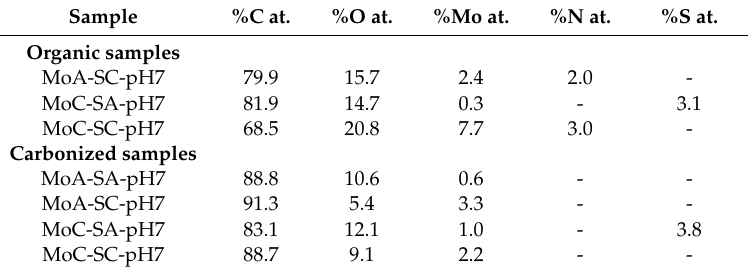
Table 1. Atomic surface composition of Mo-doped xerogels obtained by XPS analyses before and after carbonization. Sample %C